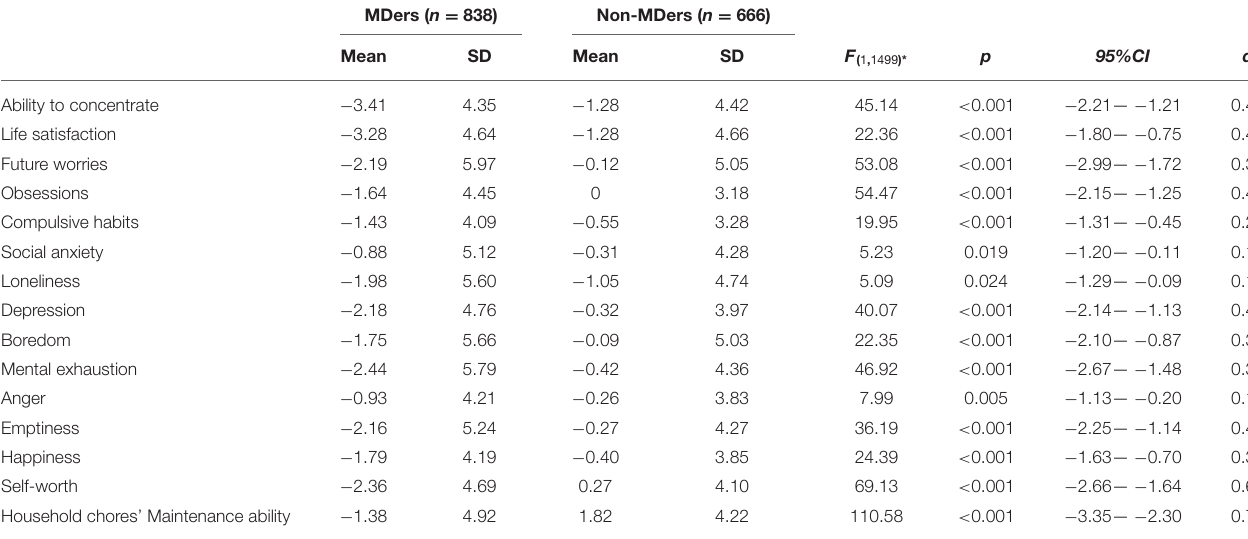
TABLE 3 | Post-hoc ANCOVA results of the MDers and non-MDers’ differences in worsened psychosocial indicators due to the COVID-19 pandemic. MDers ( n = 838) Non-MDers ( n =